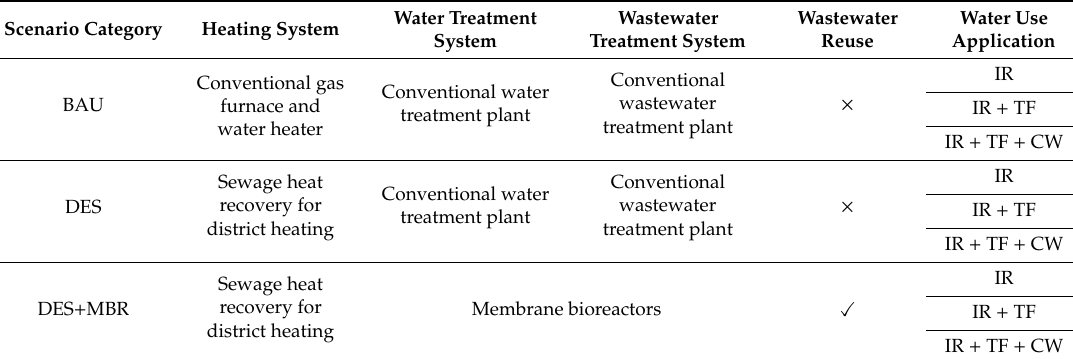
Table 1. LCA study scenario